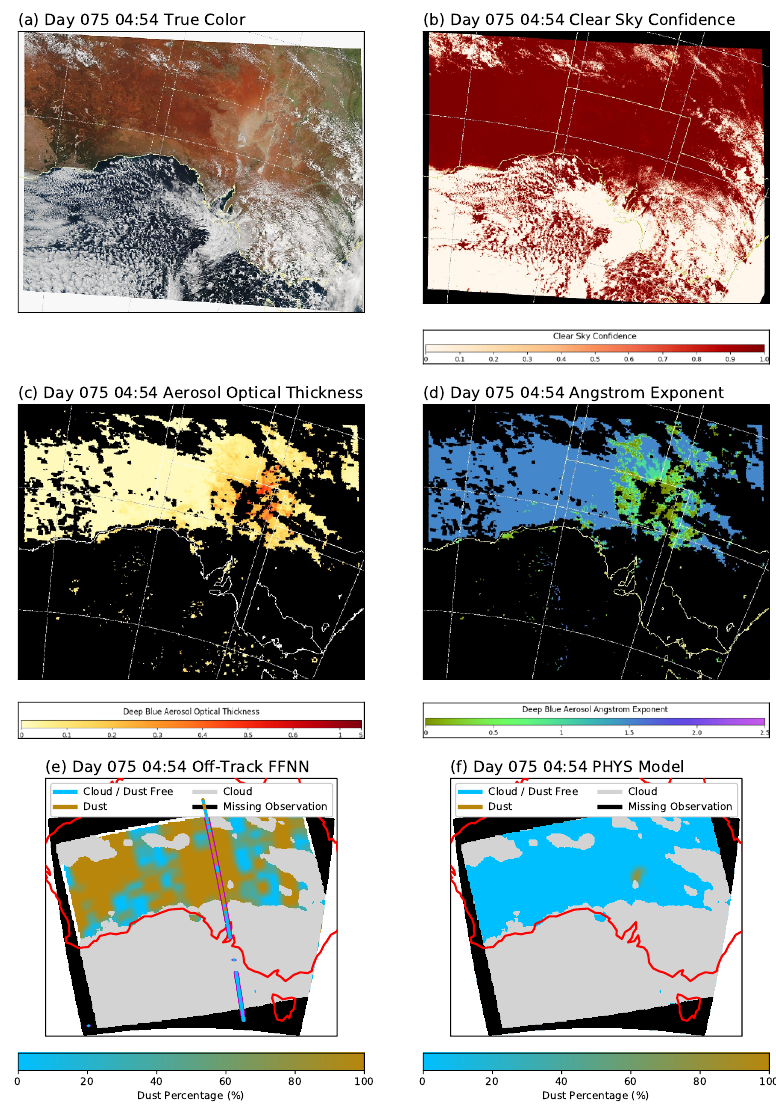
Figure 10. A case study over Arabian peninsular on day 075, at 04:54. ( a – d ) depict an image from Wisconsin’s VIIRS quicklook, where ( a ) represents the true color, ( b ) Clear Sky confidence, ( c ) Aerosol Optical Thickness, and ( d ) Angström Exponent; ( e ) FFNN results on the same geolocation. Results are plotted in a 0.1 × 0.1 latitude and longitude grid, and the percentage of dust within the grid are shown as colors. Thin magenta lines show the CALIOP swath of this region. Pixels within the magenta lines are the CALIOP product. ( f ) same as ( e ), but for a PHYS